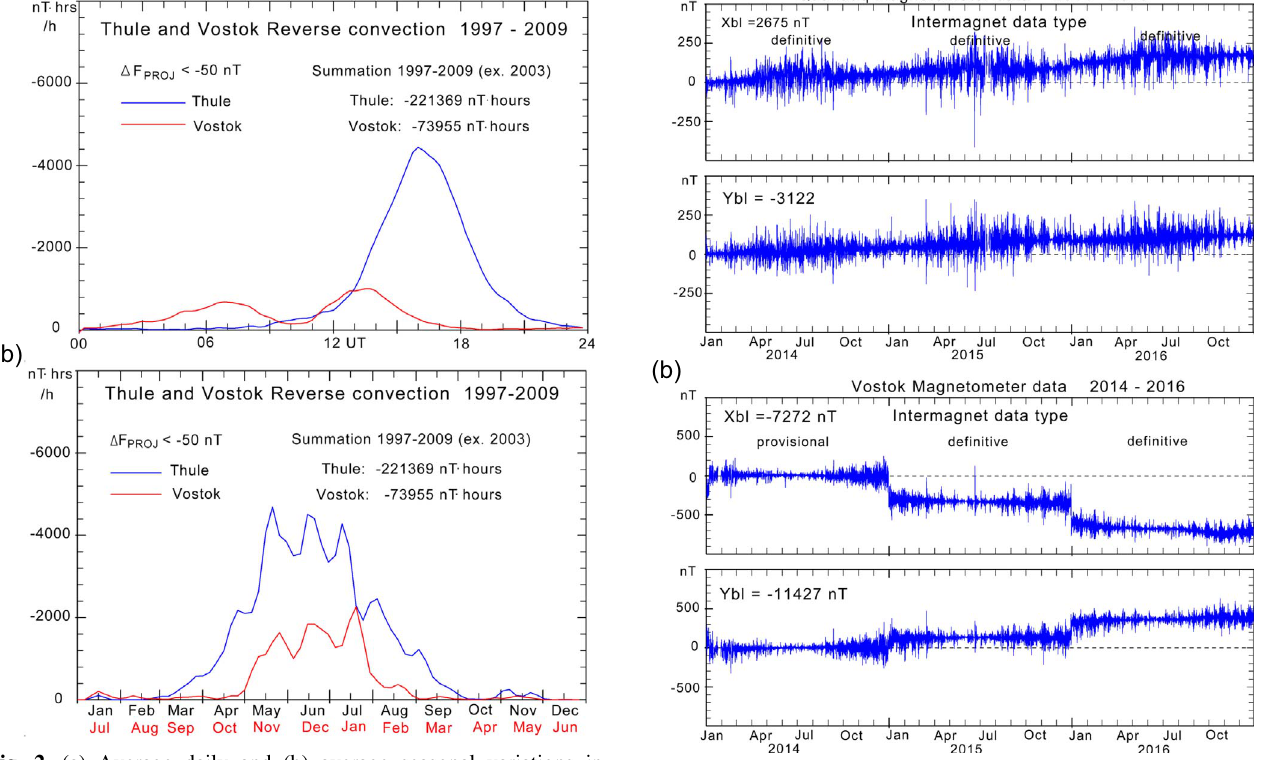
Fig. 3. Display of hourly values of the X and Y components of magnetic data from Qaanaaq (THL) and Vostok (VOS) using fi xed base line levels ( X bl , Y bl ) throughout the 3